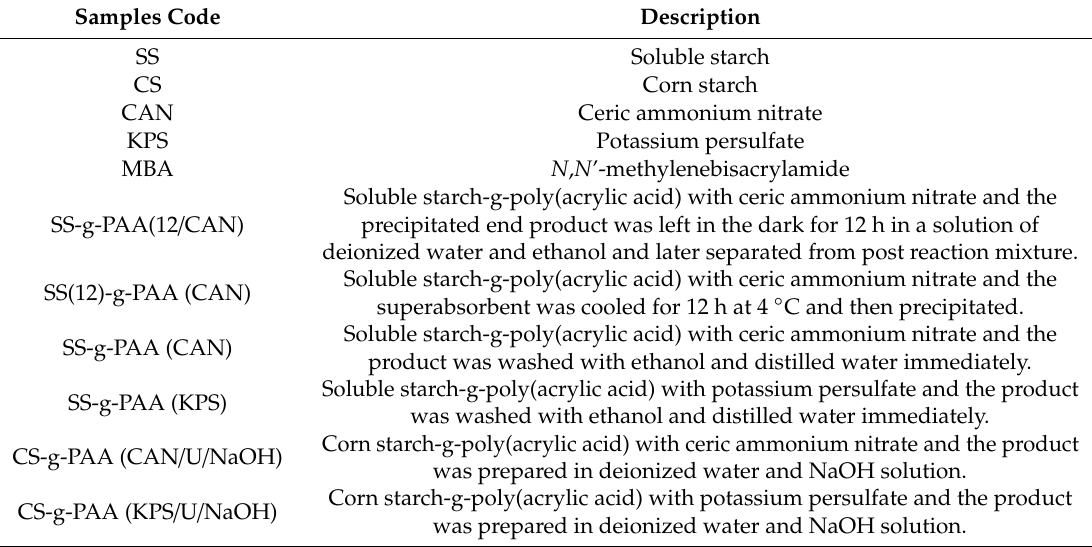
Table 1. Explanation of polymer sample